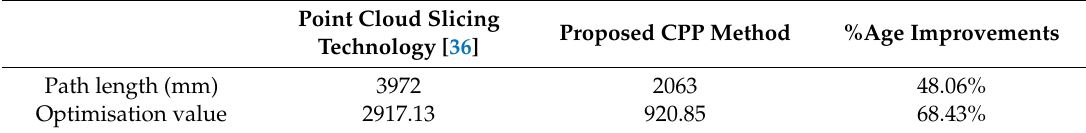
Table 4. Comparison of the two methods.